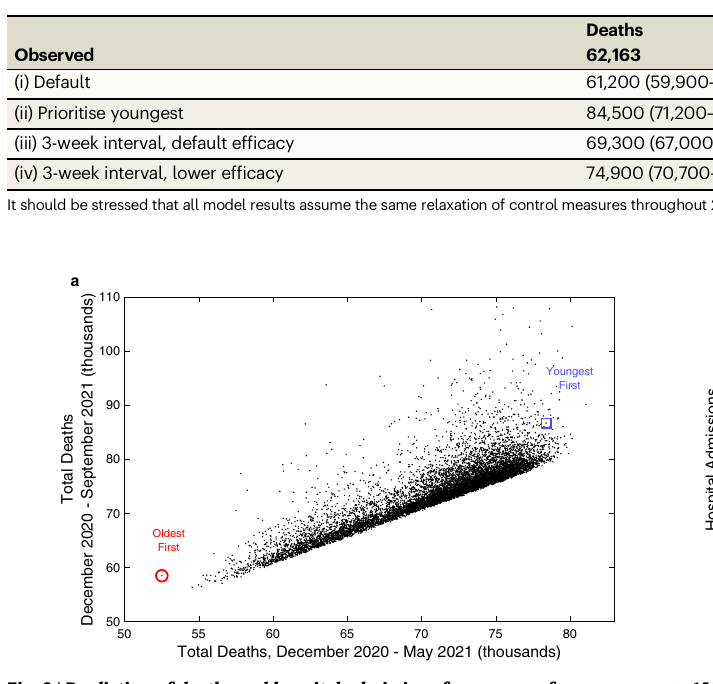
to15thMay2021, x -axis)andovertheperioduntilboosters(8thDecember2020to 1st September 2021, y -axis). We mark the results associated with vaccinating in chronological order oldest fi rst (red circle) and youngest fi rst (blue